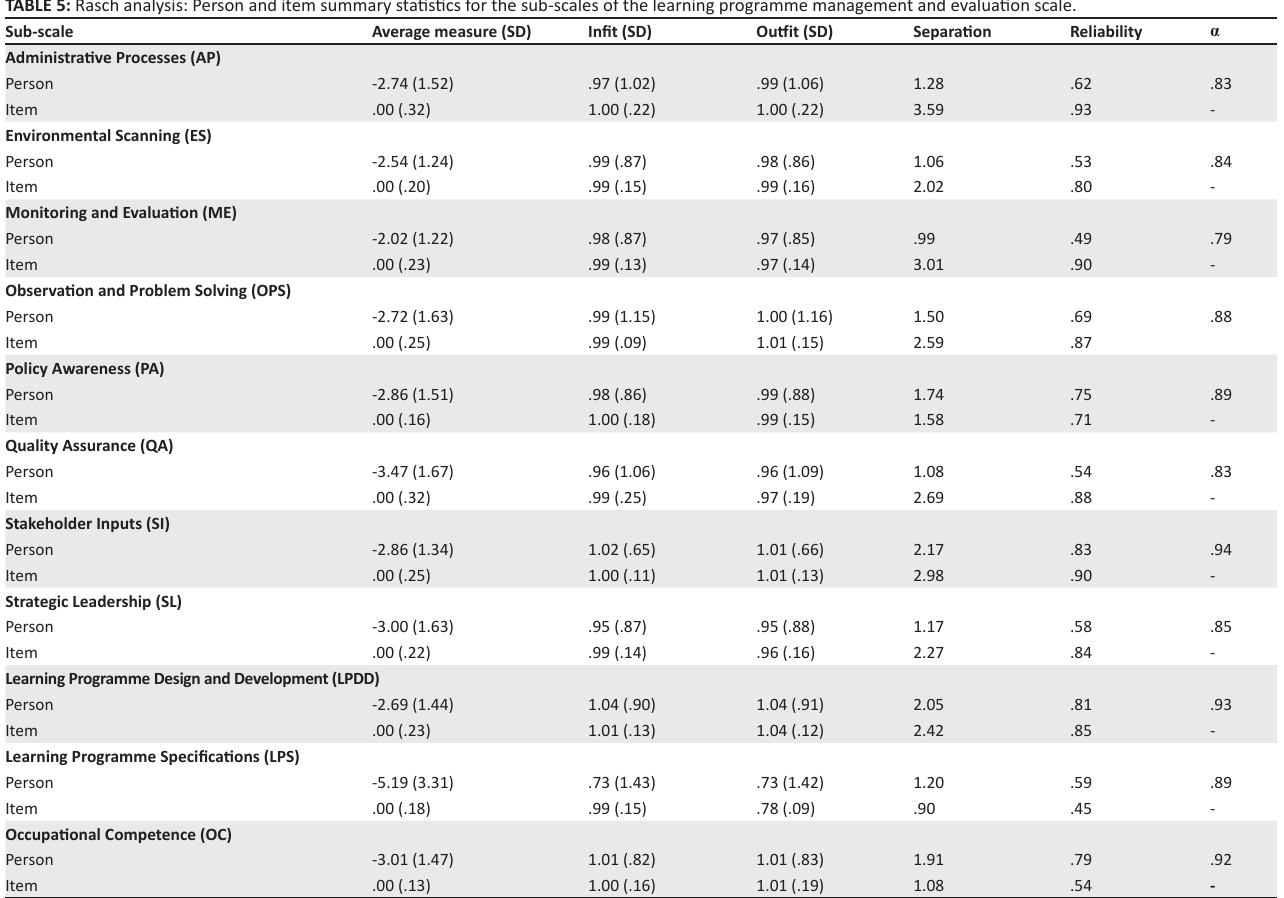
TABLE 5: Rasch analysis: Person and item summary statistics for the sub-scales of the learning programme management and evaluation scale.